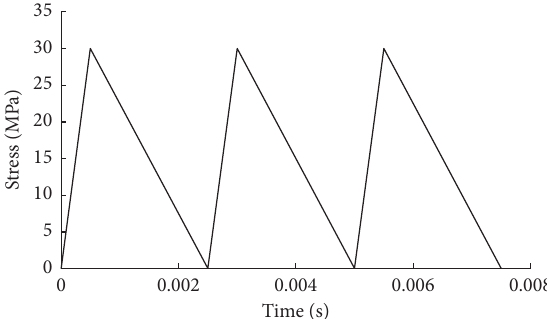
Figure 7: Multiple blasting loads acting on the tunnel.